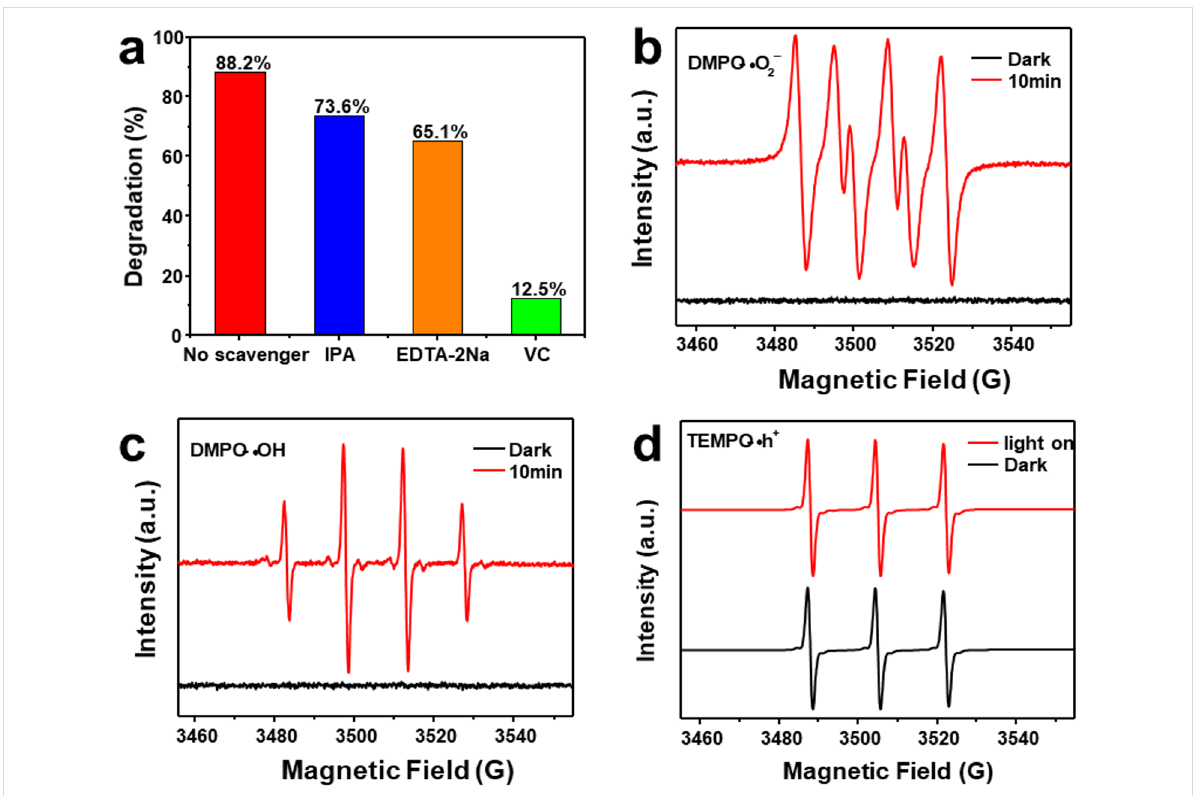
Figure 8: (a) The degradation efficiency of CTC in the presence of different scavengers. ESR spectra of (b) DMPO •O 2 − , (c) DMPO •OH, and (d) TEMPO •h + for the BOM-20 photocatalyst.